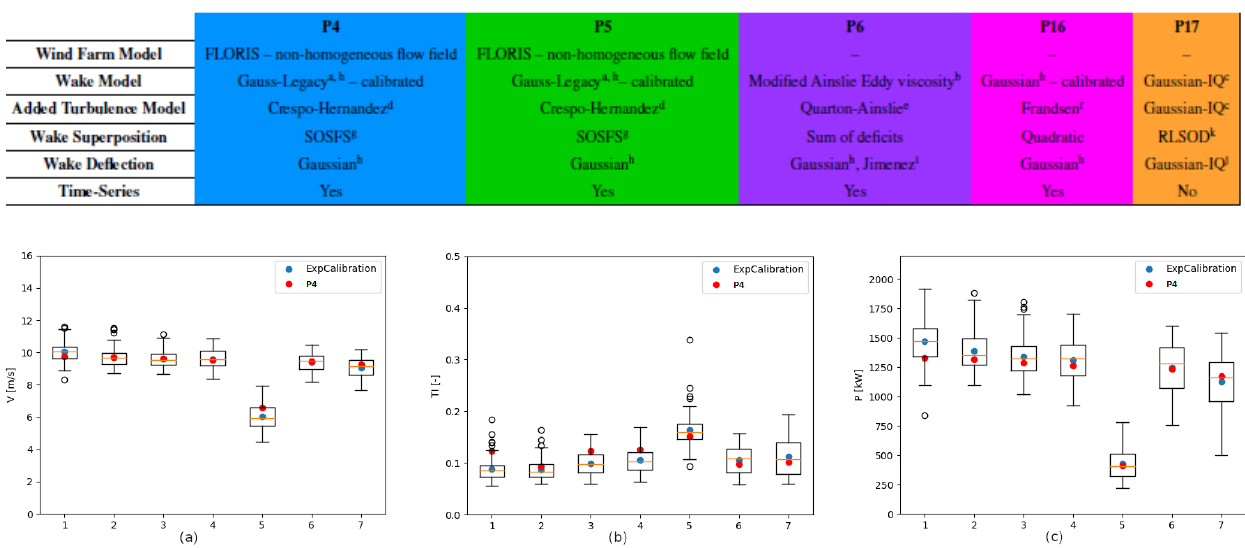
Table 3. Overview of the participating WFFC-oriented models, wind farm field data blind test. a Bastankhah and Porté-Agel (2014). b Ainslie (1988). c Ishihara and Qian (2018). d Crespo and Hernández (1996). e Quarton and Ainslie (1990) – with sum of difference. f Frandsen (2007)